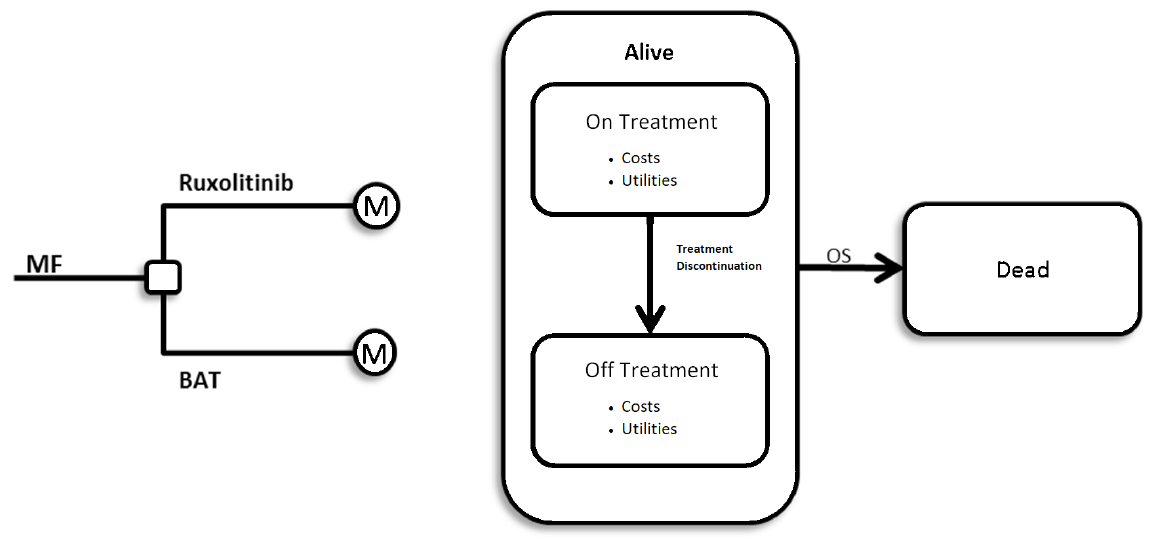
Figure 1. Decision Tree and Markov Model Health States